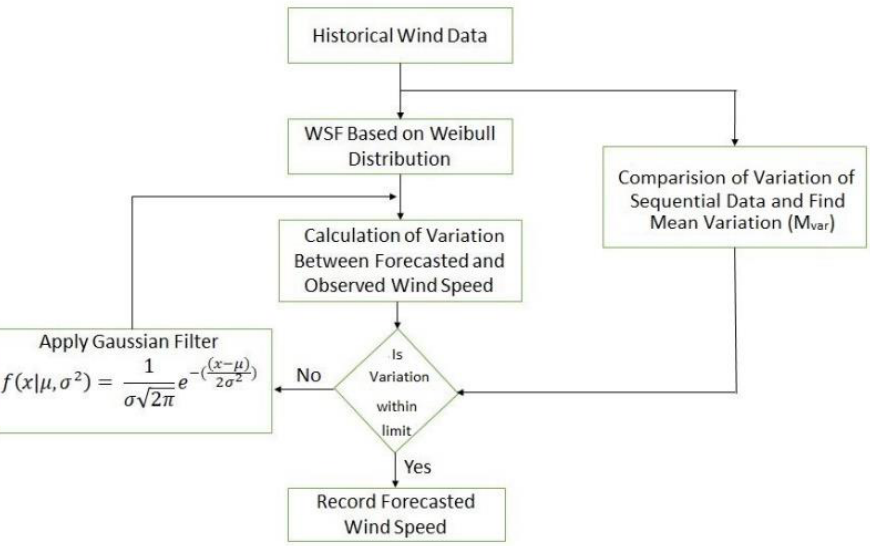
Figure 3. Error correction algorithm for simulated wind speed using Weibull and Rayleigh distribution function.